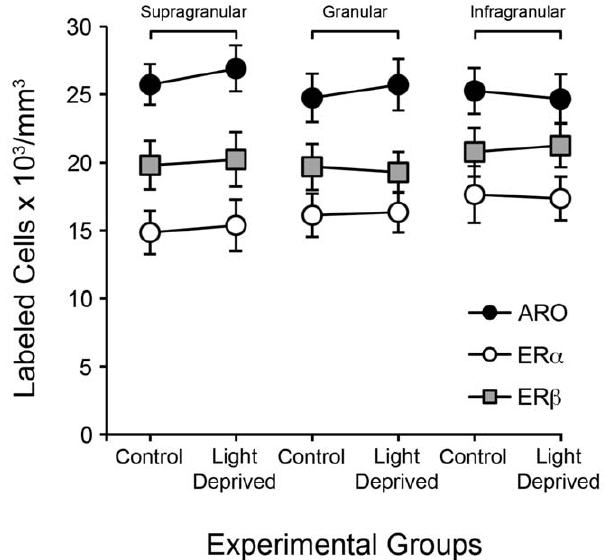
Figure 7. Chronic visual deprivation, from birth to adulthood, does not affect the density of estrogen-associated circuits in V1. Shown are the mean numerical densities ( 6 S.E.) of cells that are positive for ARO-, ER a - and ER b -positive in the V1 of control (normally- raised) and light-deprived adult mice. Data is shown for supragranular, granular and infragranular layers separately. Light-deprived animals were born and kept in complete darkness until adulthood (see Methods). No differences were detected for ARO-, ER a - or ER b , for any cortical layers, when comparing control and chronically light- deprived animals.